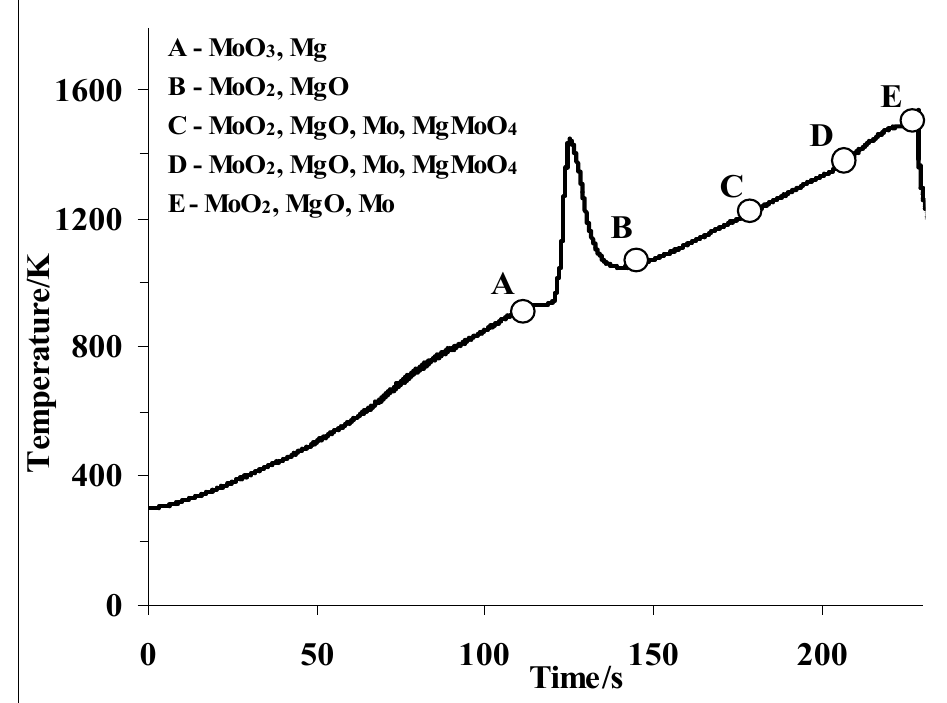
Figure 6. The heating thermogram of the MoO 3 + 3Mg mixture with the XRD analysis results of the quenched samples at different characteristic temperatures, A—T = 923, B—1048, C—1203, D—1323, E—1573 K, V h = 300 K min − 1 .